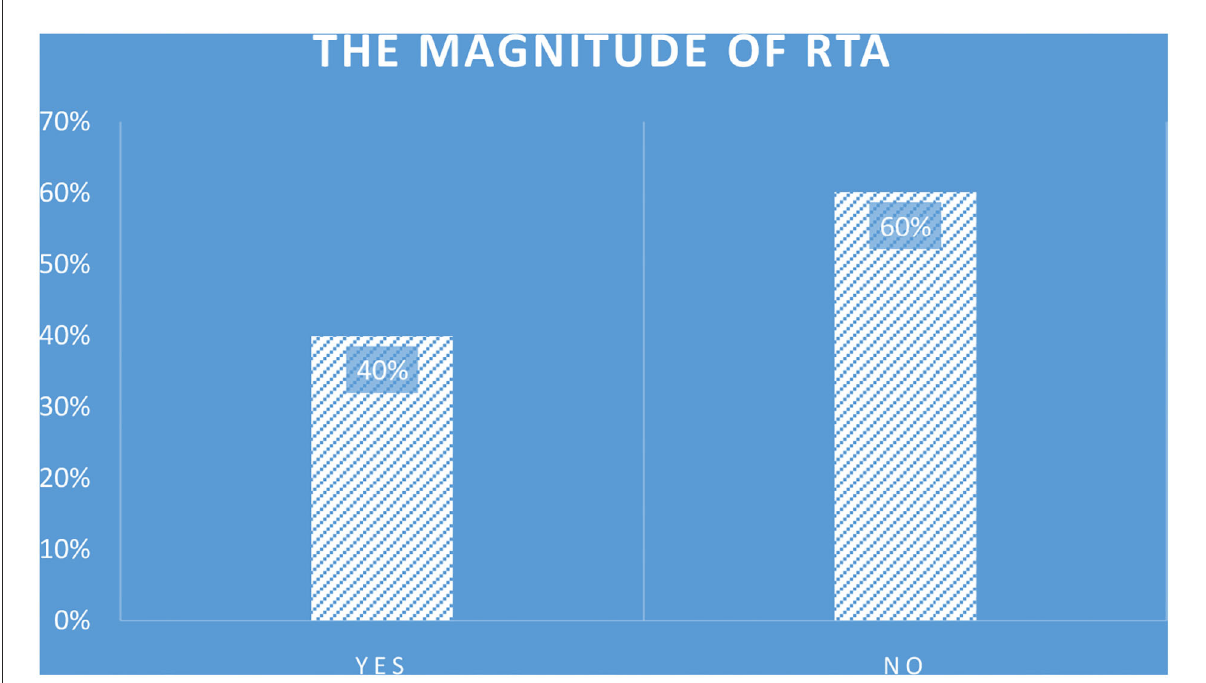
FIGURE2 The magnitude of road traffic accidents among drivers in Dilla Town, Gedeo Zone, Southern Ethiopia, 2021 (n = 316).